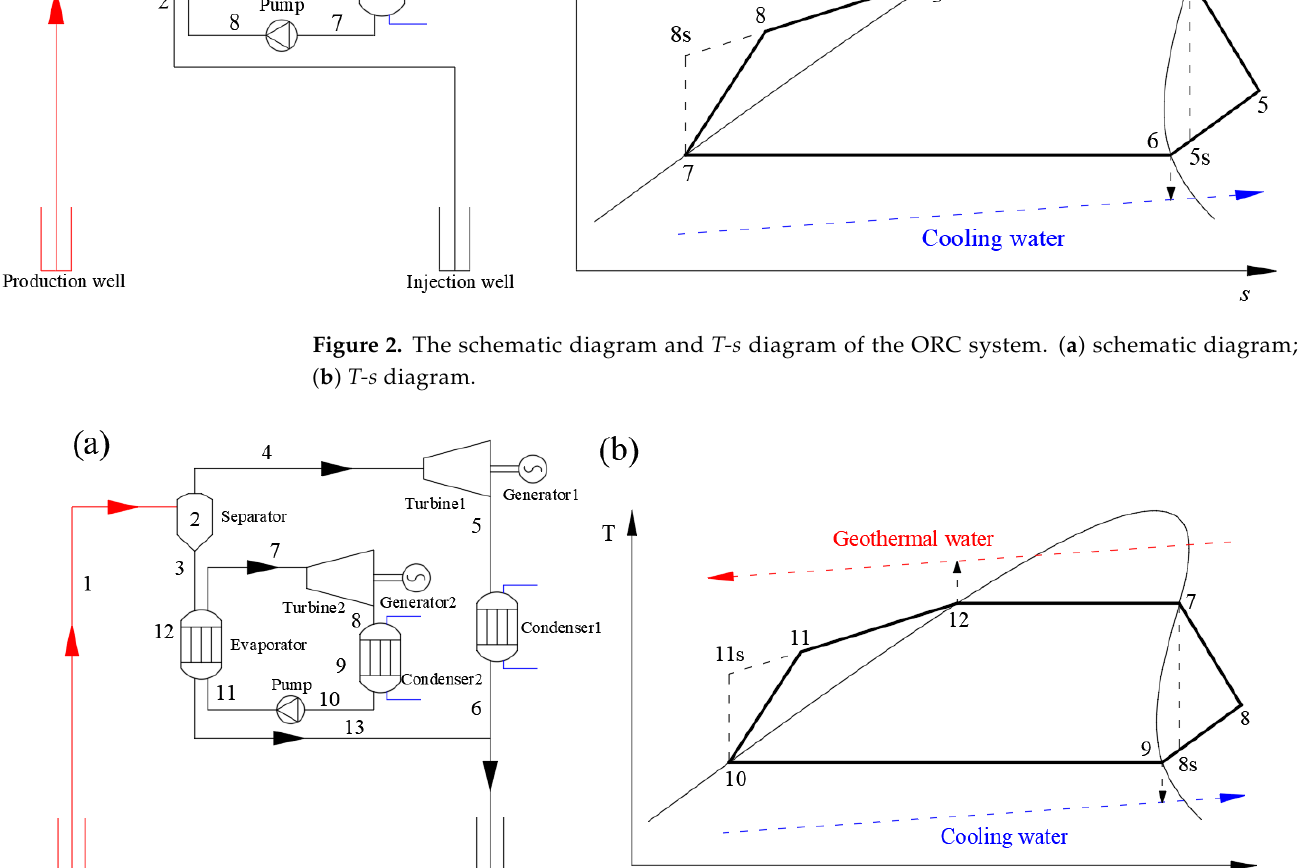
Figure 2. The schematic diagram and T-s diagram of the ORC system. ( a ) schematic diagram; ( b ) T-s diagram